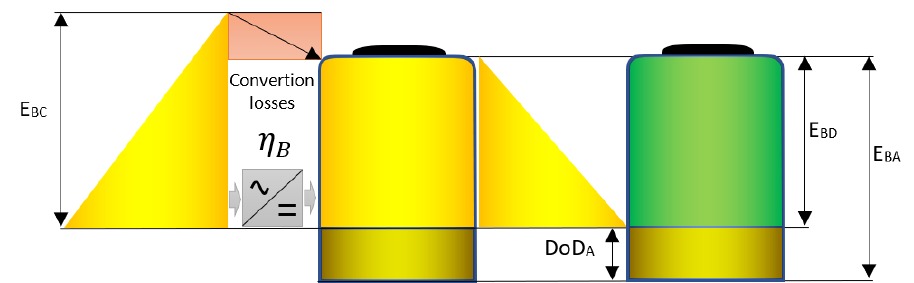
Figure 2. Examples of typical BESS operating states with markings of characteristic measures for price arbitrage.